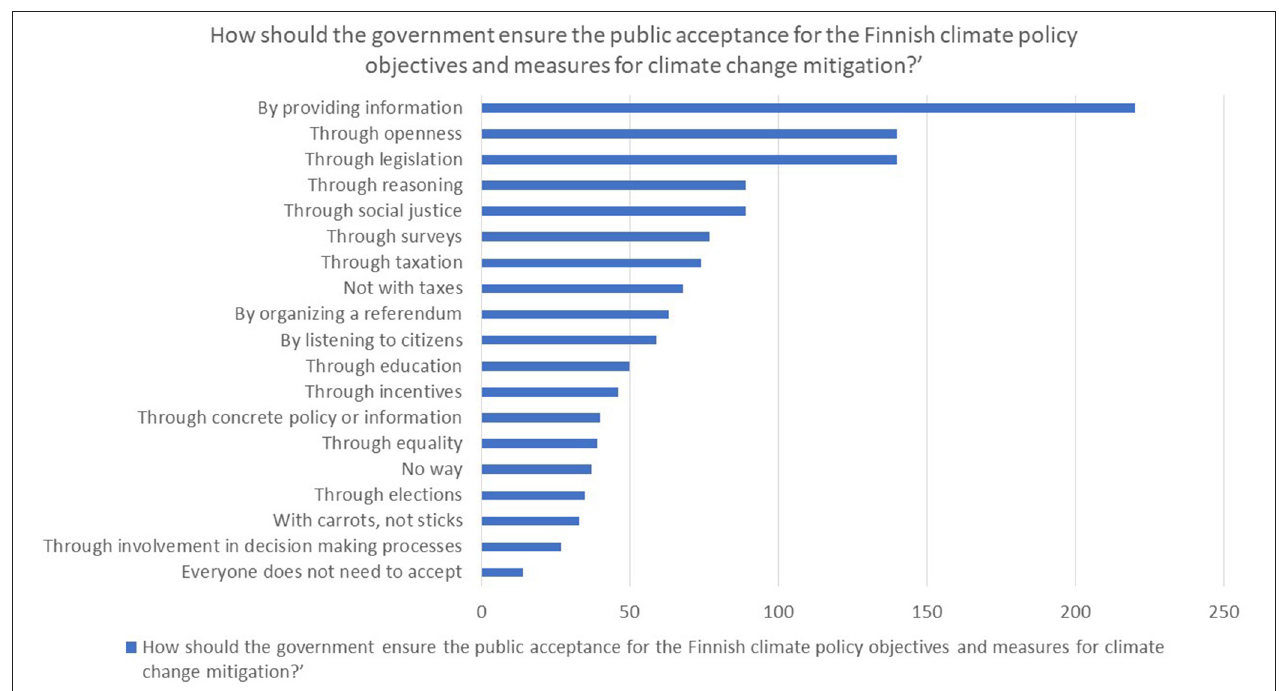
FIGURE 2 | How should the government ensure the public acceptance for the Finnish climate policy objectives and measures for climate change